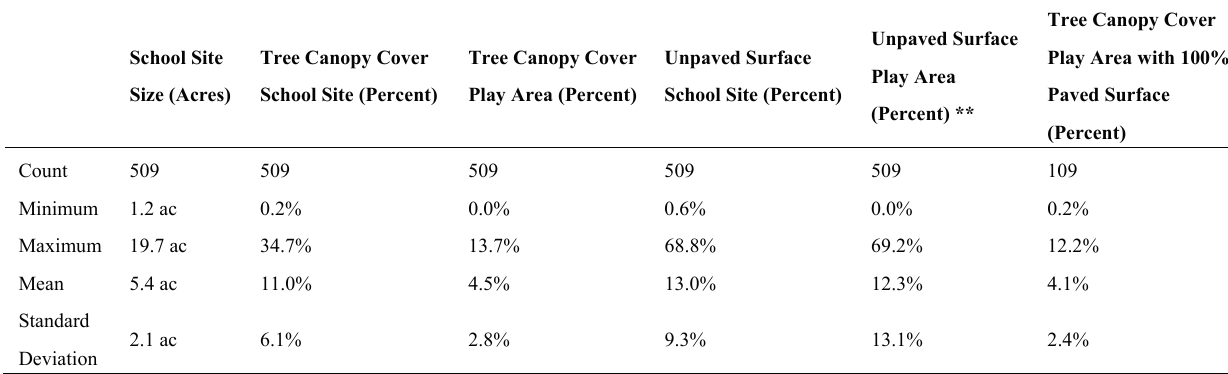
Table 1. Descriptive Measures of Elementary School Sites *.